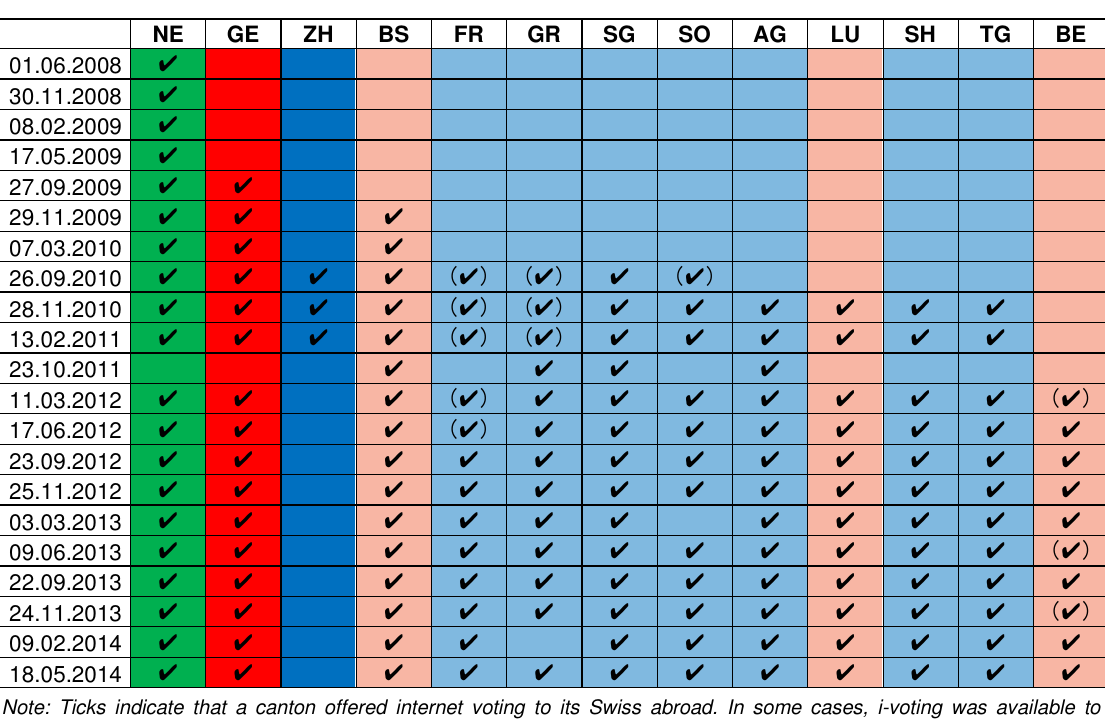
Table 1: Overview of the internet voting roll-out to expatriates (federal